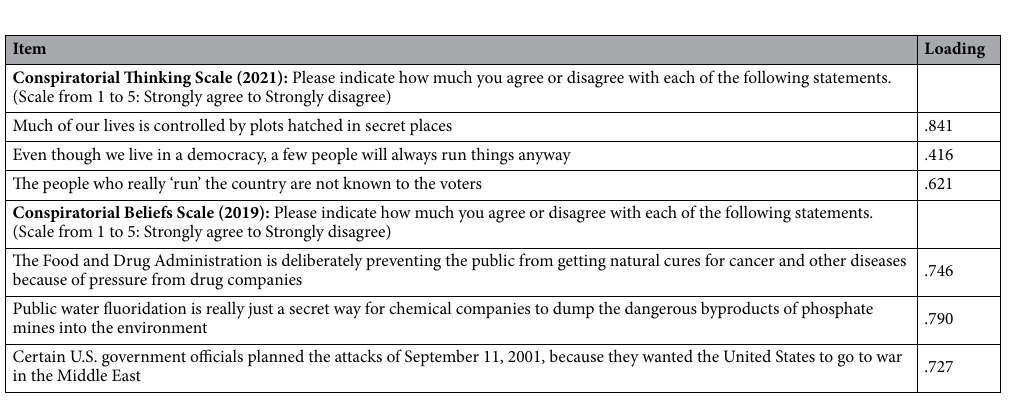
Table 4. Measures of conspiratorial thinking at both